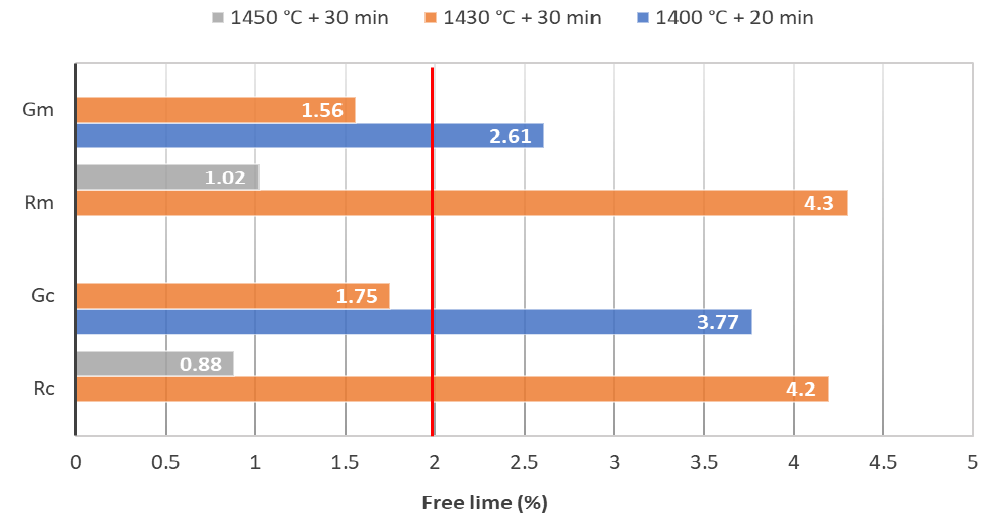
Figure 3. Free lime assessed on the clinkers obtained by calcination at different temperatures and plateaus (red line = maximum free lime content recommended in clinkers).